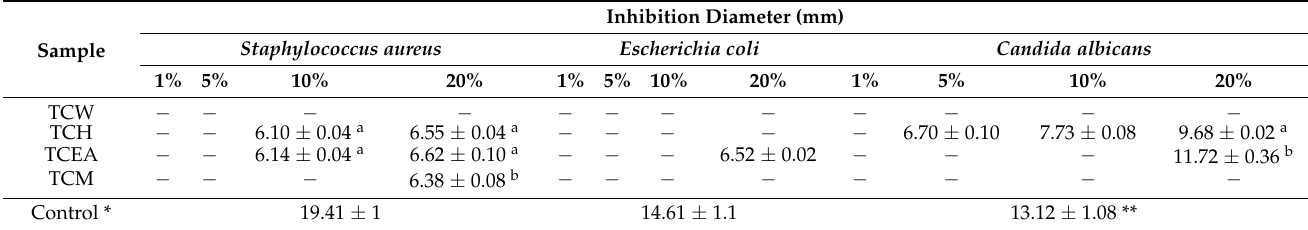
Table 2. Antibacterial and antifungal activities of cocoa pod husk extracts.